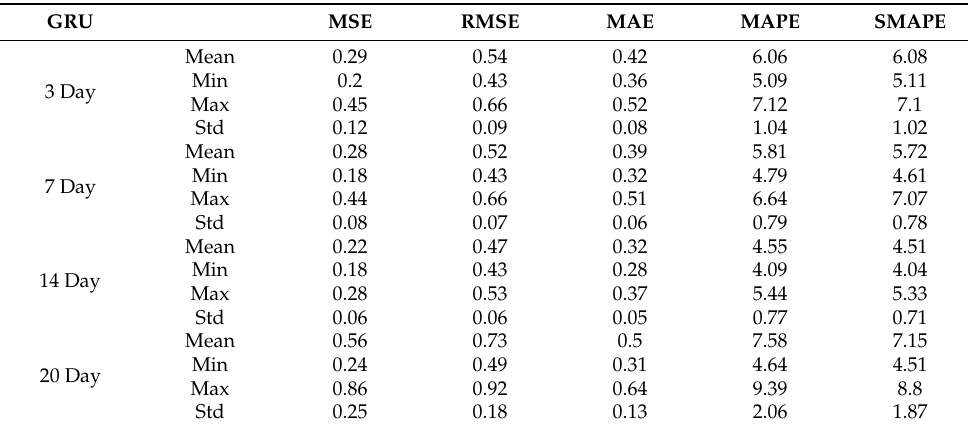
Table 1. Prediction accuracy of GRU under different windows.